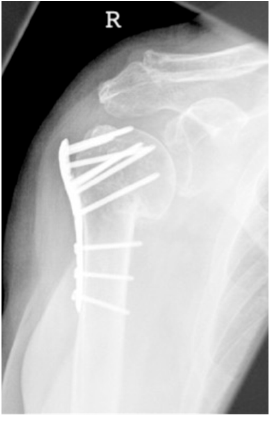
Figure 8. Complication Type 2a. a.p. radiograph of the right shoulder after angular stable plate osteosynthesis shows moderate varus displacement of the humeral head. The most cranial screw breaks through the humeral head cortex (screw cutout).